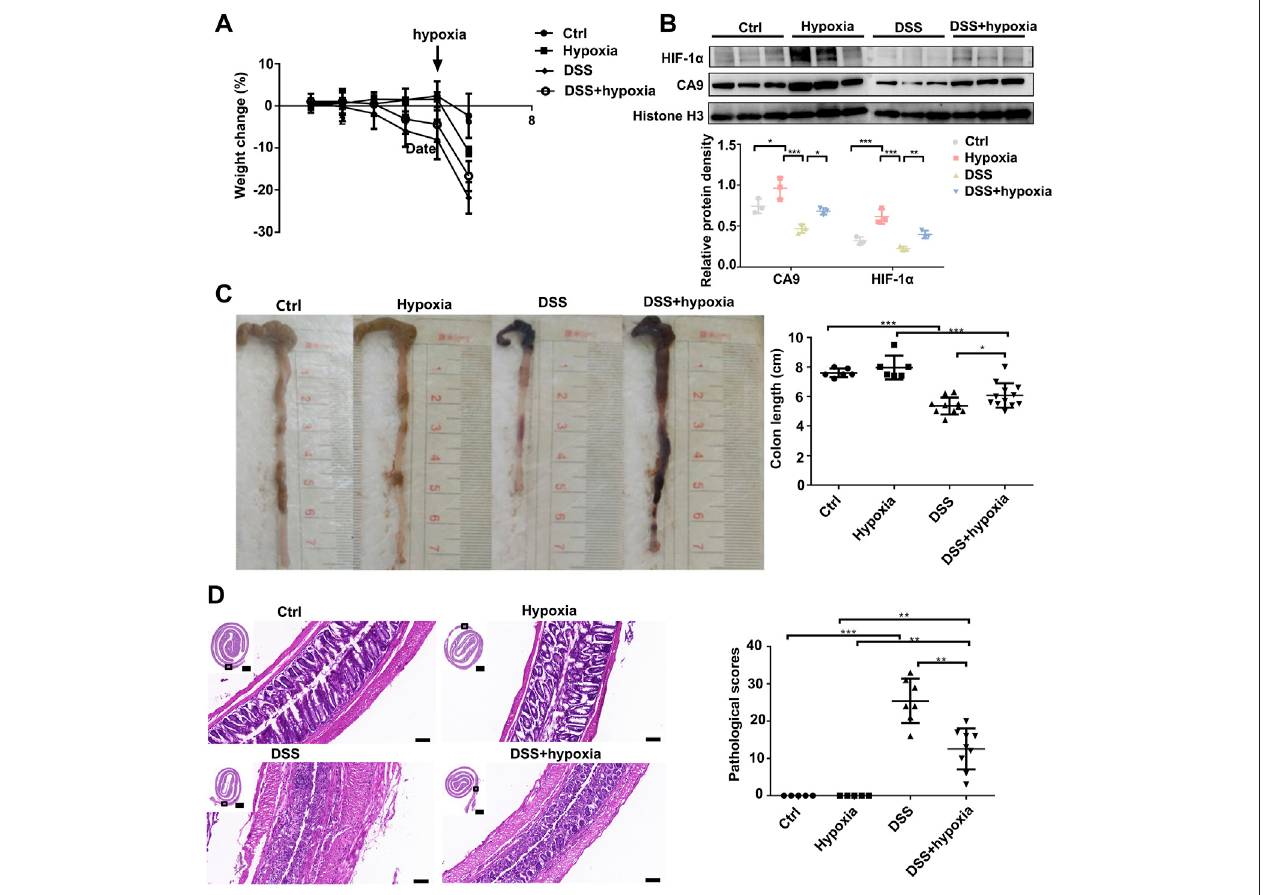
FIGURE 1 | Hypoxia ameliorated DSS-induced colitis in mice. (A) : The body weight change of Ctrl, control group; hypoxia, hypoxia-only group; DSS colitis group (DSS),andcolitistreatedwithhypoxiagroup(DSS+hypoxia);onday 5,thehypoxiagroupwasgiven1%O 2 stimulation. (B) :HIF-1 α andCA9(Carbonatedehydratase9) expression by Western blotting in each group. (C) : Length of the colon at the end of the experiment in each group. (*** P < 0.001, * P < 0.05). (D) : The HE staining of the colon and their pathological scores in each group. (*** P < 0.001, ** P < 0.01). Bars = 2000 μ m or 100 μ m.